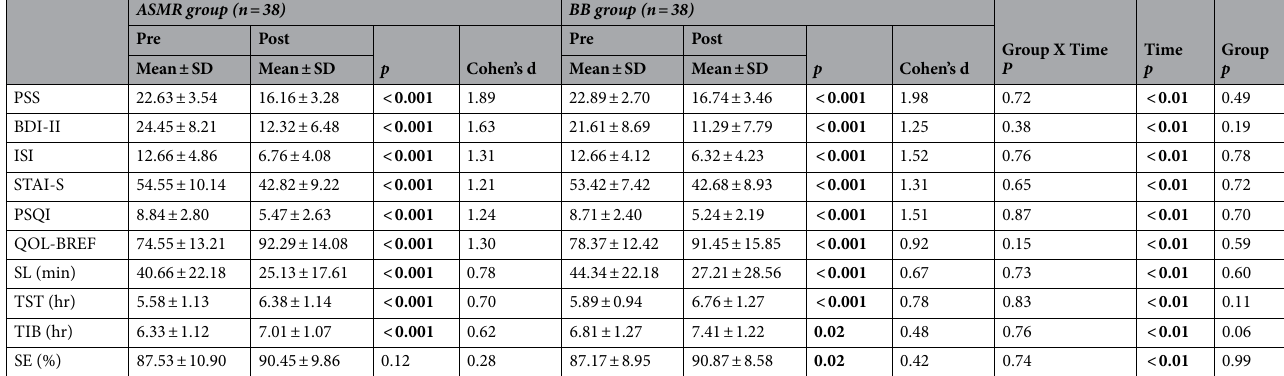
Table 2. Mean comparison of questionnaires and sleep parameters before and after application use. Significant values are in bold. Paired t-test was performed to examine within-group differences. Cohen’s d was calculated to estimate the effect size. Repeated measures analysis of variance (RM ANOVA) was used to examine group- by-time interaction. PSS : Perceived stress scale, BDI-II : Beck depression inventory II, ISI : Insomnia severity index, STAI-S : State-trait anxiety inventory-state anxiety, PSQI : Pittsburgh Sleep Quality Index, QOL-BREF : Quality of Life scale abbreviated version, SL : Sleep latency, TST : Total sleep time, TIB : Time in bed, SE : Sleep efficiency, ASMR : Autonomous sensory meridian response, BB : Binaural